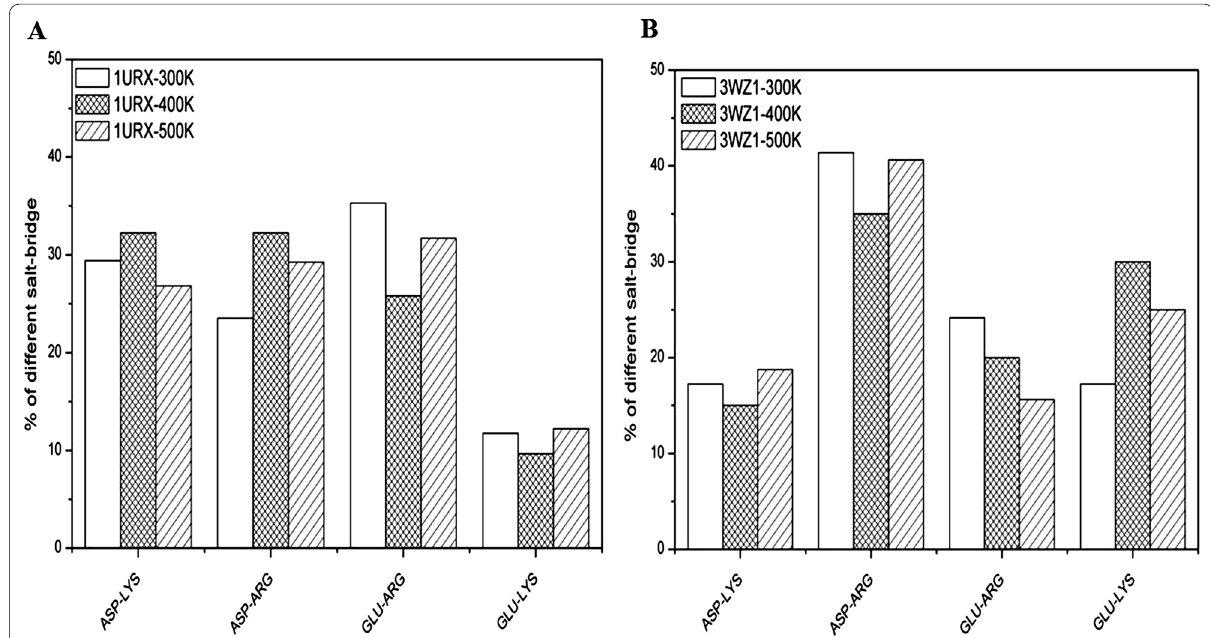
Fig. 8 The variation of salt bridges in 1URX ( A ) and 3WZ1 ( B ) at different